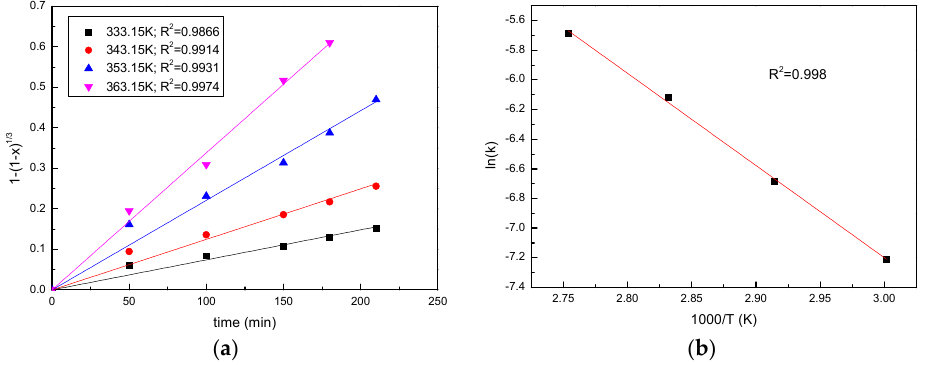
Figure 7. Analysis of activation energy ( a ) Plots of 1 − (1 − x ) 1/3 vs. time for manganese; ( b ) Arrhenius plot of ln( k ) vs. 1000/T at different temperatures.